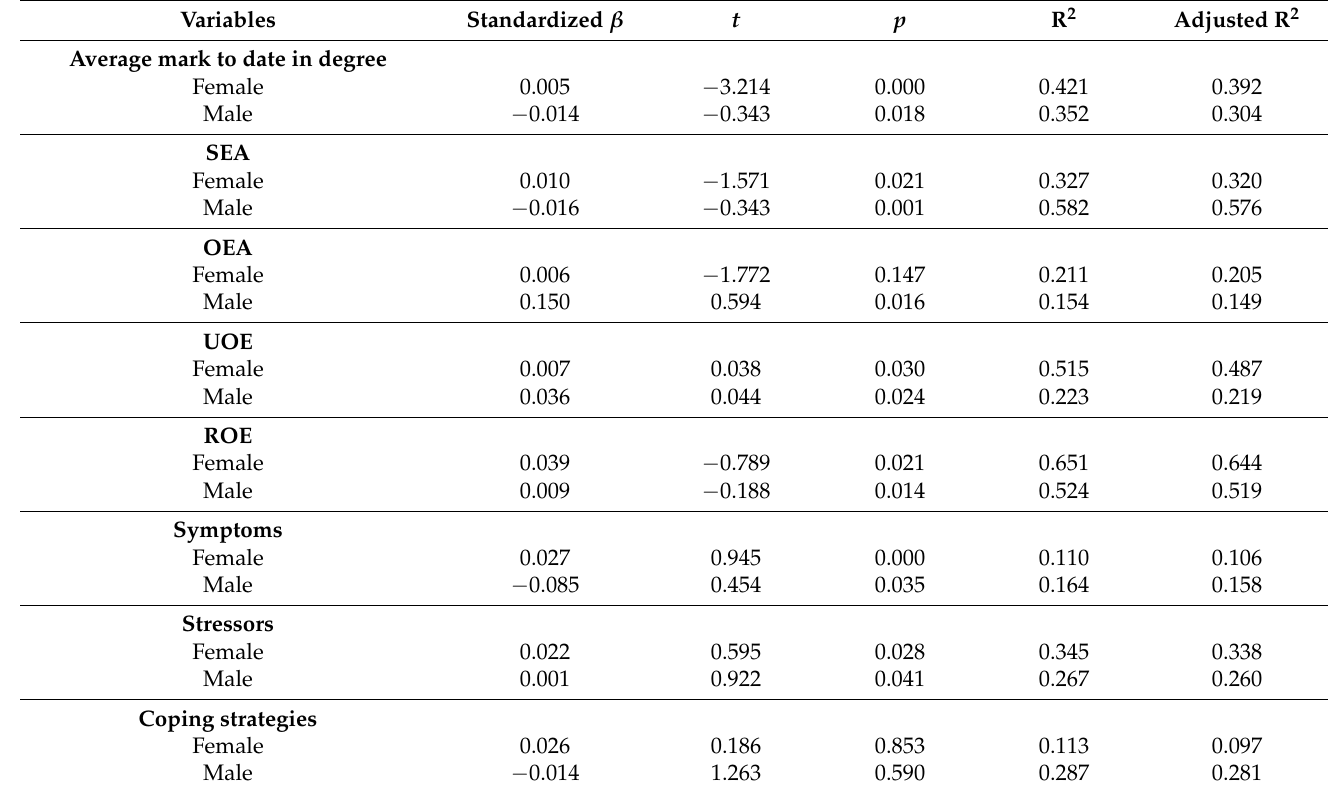
Table 4. Bivariate correlations among EI and academic stress categories for